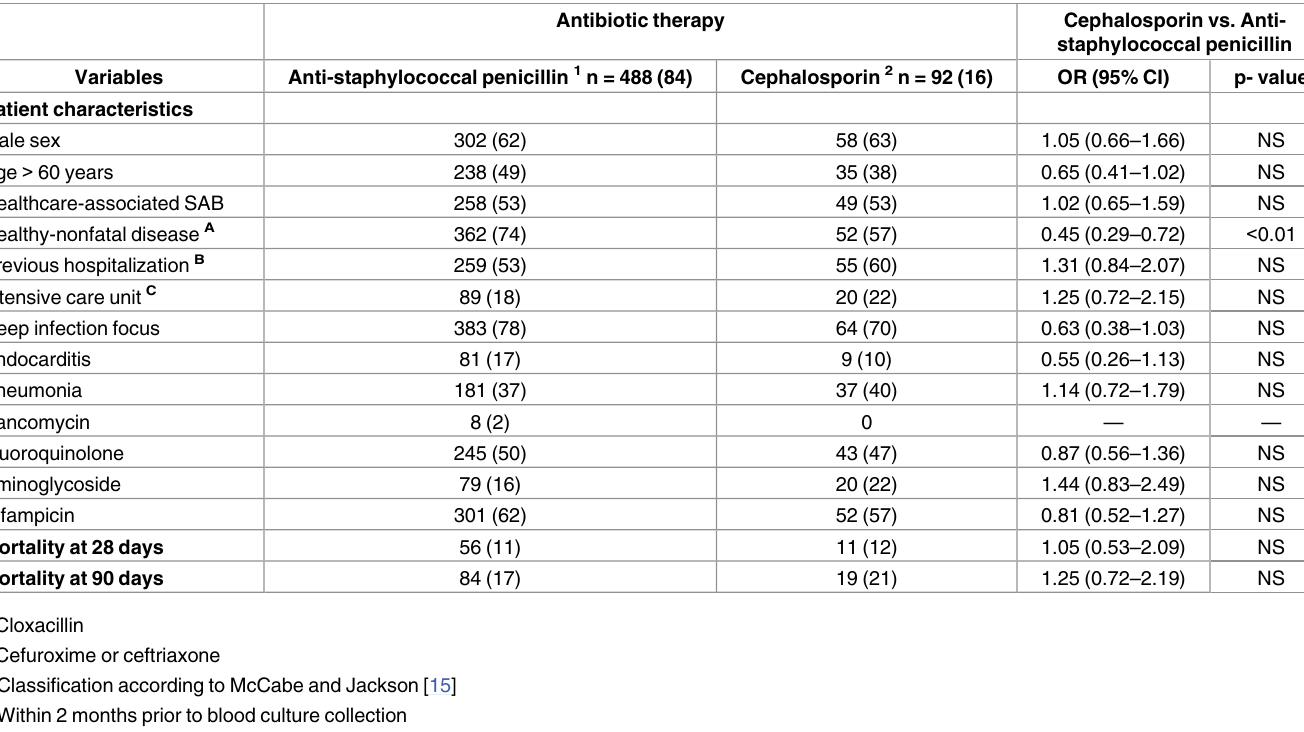
Table 1. Patient characteristics, severityof illness, treatment management and outcome of 580 patients with methicillin-sensitive Staphylococcus aureus bacteraemia (SAB). Patients are categorised accordingto first week antimicrobial therapyinto anti-staphylococcalpenicillinor cephalosporin. Values are n (%). NS =